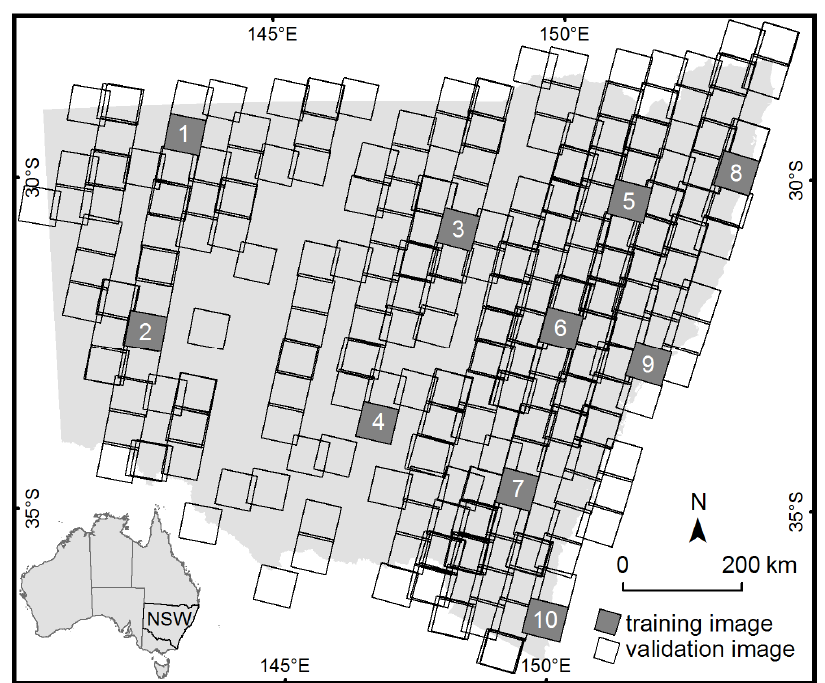
Figure 1. Location of the cloudy Satellite pour l’Observation de la Terre 5 (SPOT5) High Resolution Geometrical (HRG) images over New South Wales, Australia (2004–2012) used to train and validate the SPOT cloud and shadow masking (SPOTCASM) method. The 10 numbered scene boundaries show the location of the training images used to develop the